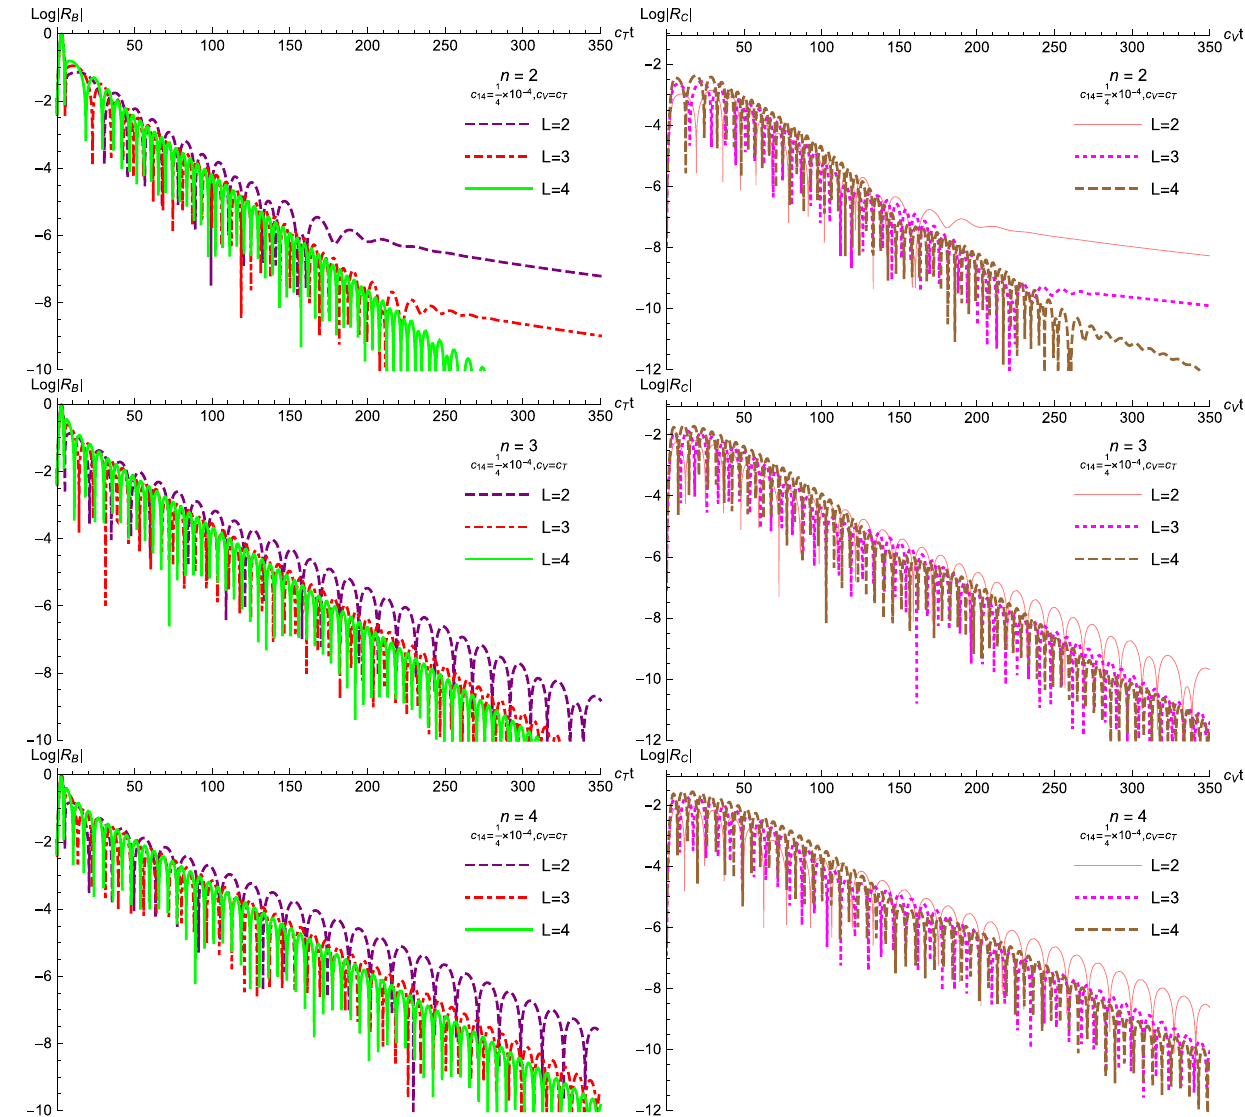
Fig. 4 The time profiles of axial gravitational quasinormal modes for R B and R C for the metric parameter c 14 =